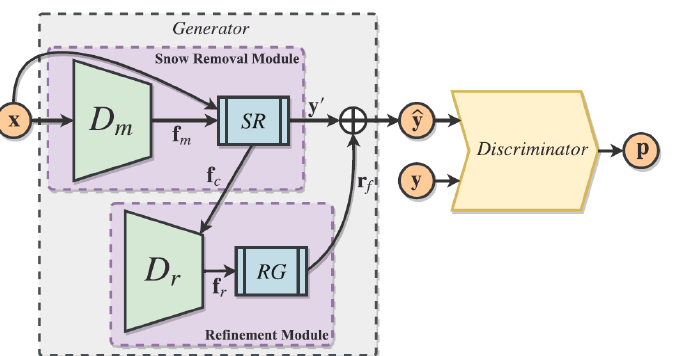
Figure 7. Schematic of the DesnowGAN method by Jaw et al. [107]. A GAN-based snow removal module, a refinement module and a discriminator module guide single image